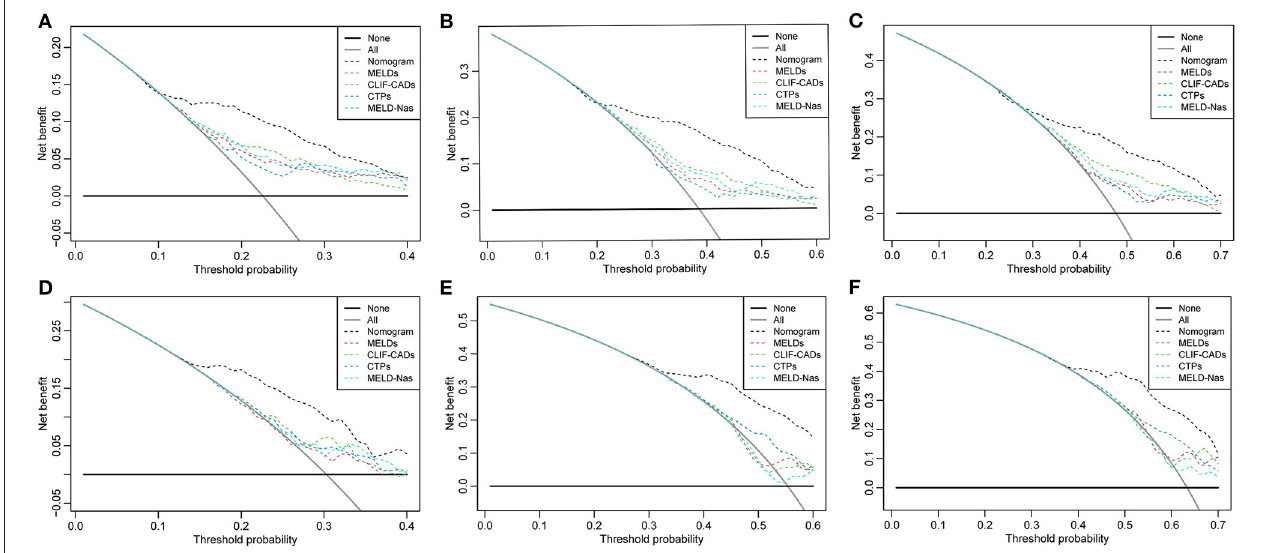
FIGURE 4 | Decision curve analysis at 30, 60, and 90 days for the derivation cohort (A–C) and the temporal validation cohort (D–F) . The horizontal solid black line represents the assumption that no patients will experience the event, and the solid gray line represents the assumption that all patients will relapse. On decision curve analysis, the readmission nomogram showed superior net benefit compared with other models across a range of threshold